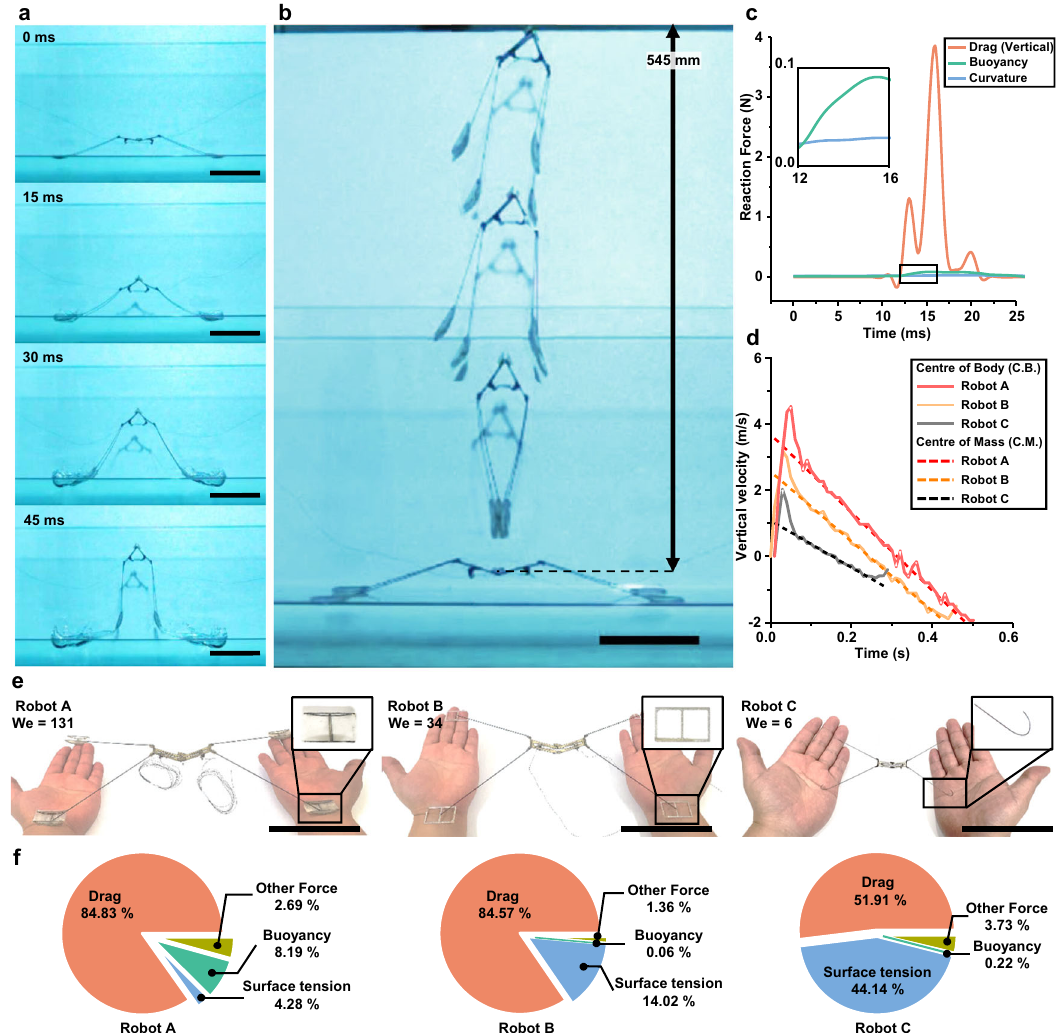
Fig.3|Experimentalresultsofverticaljumpingonthewatersurface.a Jumping sequence of the vertical jumping robot (Robot A). Scale bar, 10cm. b Composite image ofrobot Ajumping on the watersurface. The robot jumps at545mm on the water ’ s surface. Scale bar, 10cm. c The change of drag, surface tension, and buoyancy force while robot A takes off on the water. Only the vertical force com- ponents are considered. d The vertical velocity of robot A, robot B, and robot C